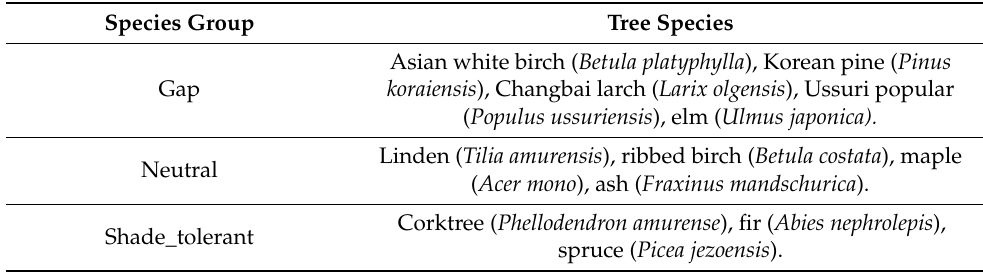
Table 3. List of tree species group classification. Species Group Tree Species Gap Linden ( Tilia amurensis ), ribbed birch ( Betula costata ), maple Neutral ( Acer mono ), ash ( Fraxinus mandschurica ). Shade_tolerant spruce ( Picea jezoensis